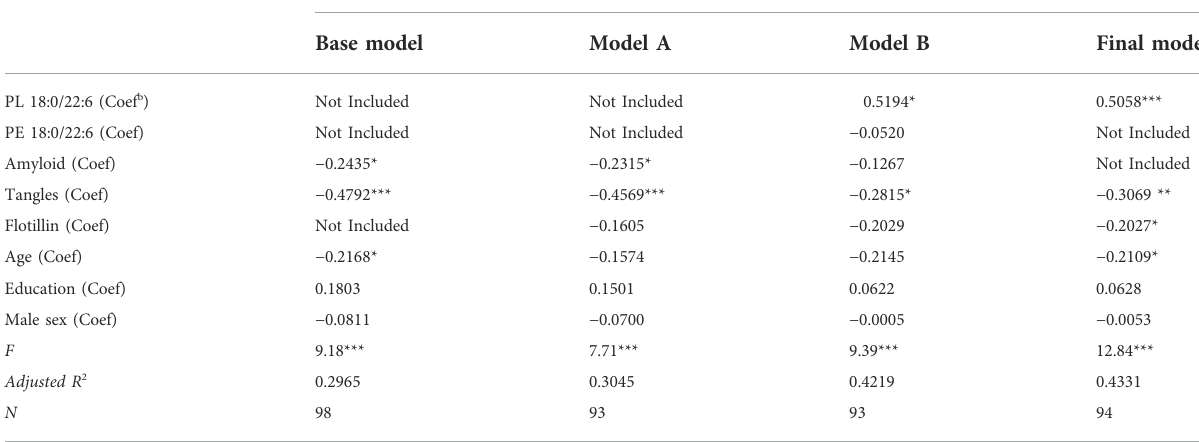
TABLE 4 Association of amyloid, tangles, fl otillin and phospholipids with cognition. Variable